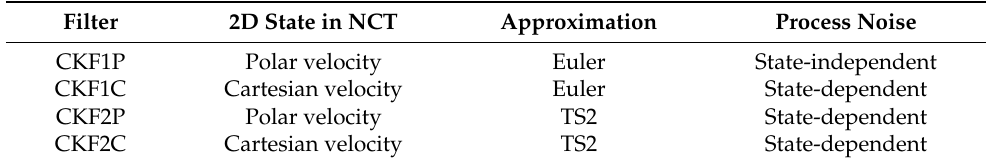
Table 1. Features of CKF based